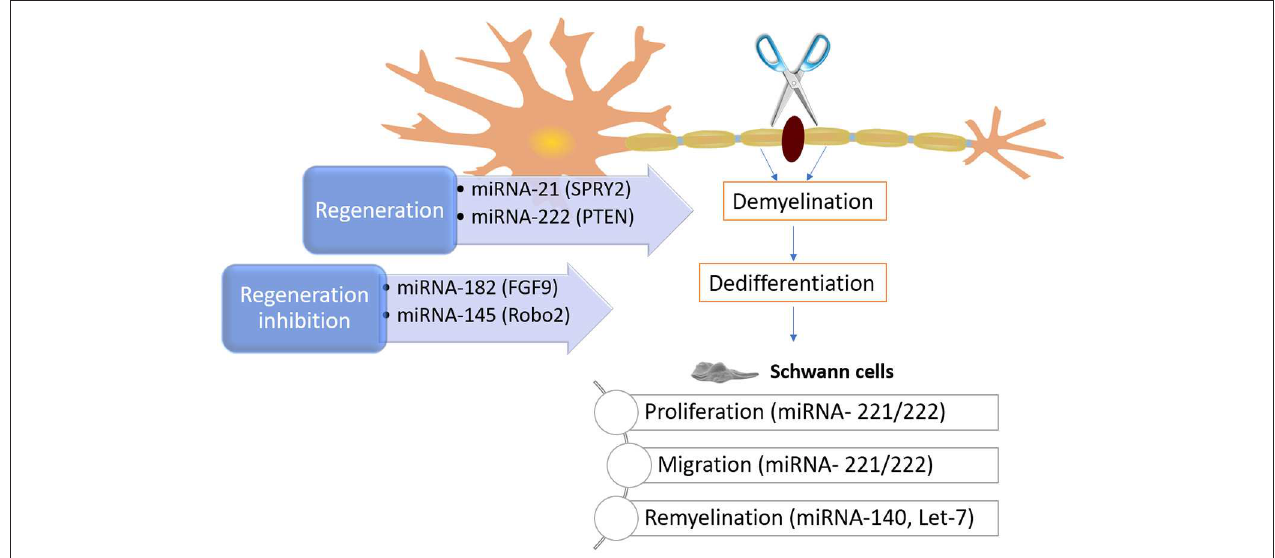
FIGURE 9 | Schematic on some known mechanisms of how miRNAs can intrinsically control and impact peripheral nerve injury and regeneration. After an injury, the myelin and axons degrade, and Schwann cells dedifferentiate. As these phenomena happen, the molecular regulators (e.g., miRNA-221, miRNA 222, and Let-7) can influence neurite outgrowth and modulate phenotypic changes in Schwann cells, as well as their myelinating capacity, among